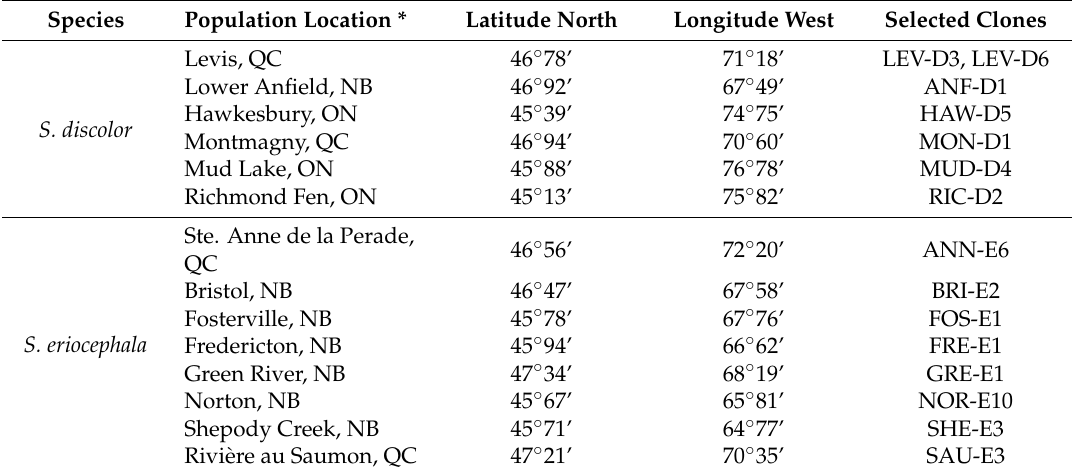
Table 1. Origins of 15 Salix discolor and S. eriocephala genotypes used for measurements of foliar uptake of nutrients and metals from two common-garden studies at the Salmon Harbour mine site near Minto, New Brunswick